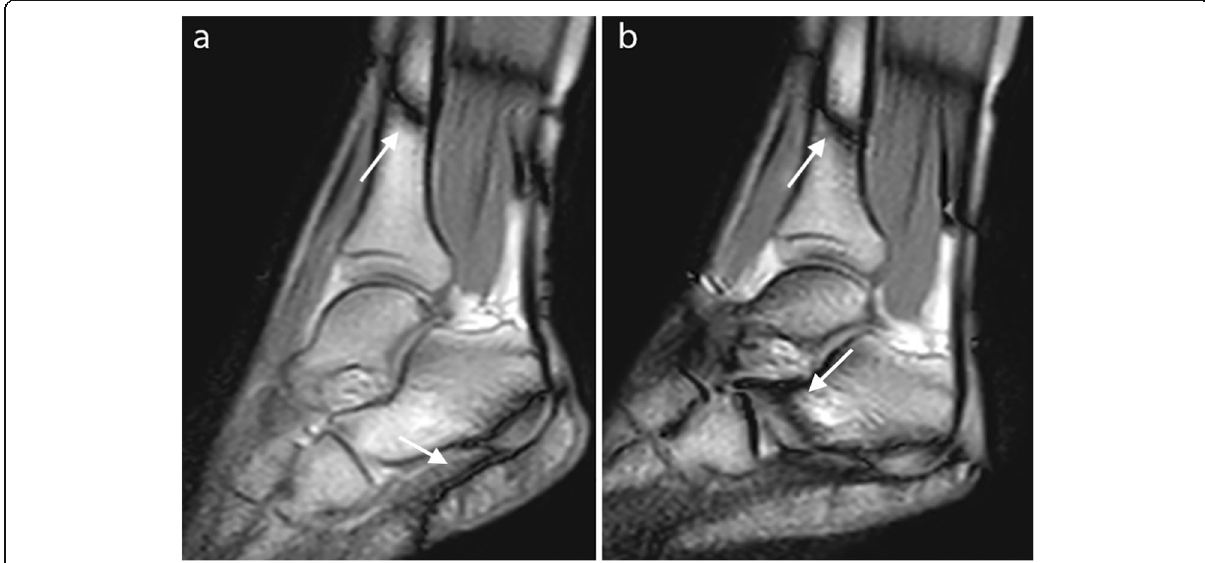
Fig. 8 Sagittal balanced SSFP image of the ankle in plantar ( a ) and dorsal ( b ) flexion. Band artifacts appear as black lines that move on the image during